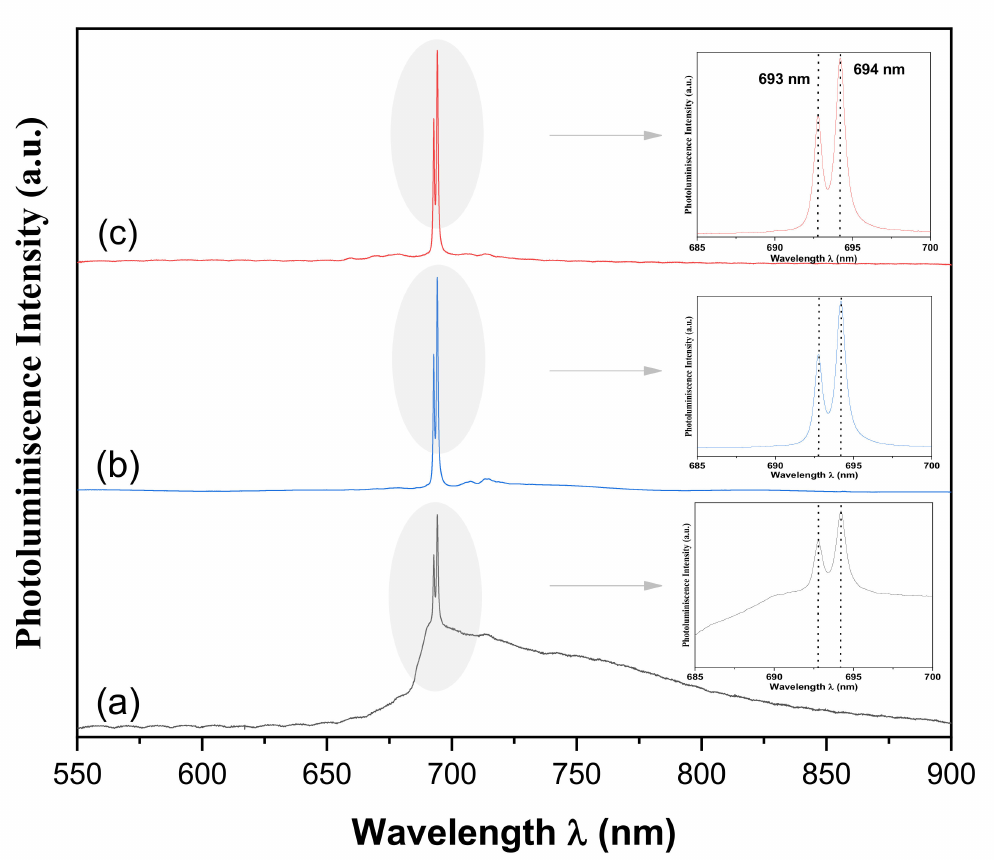
Figure 9. Photoluminescence spectra of SiO 2 -ZrO 2 with CO 2 laser post-annealing for 1 min, using a power density of ( a ) 0.69 W/cm 2 ; ( b ) 1.04 W/cm 2 and ( c ) 1.38 W/cm 2